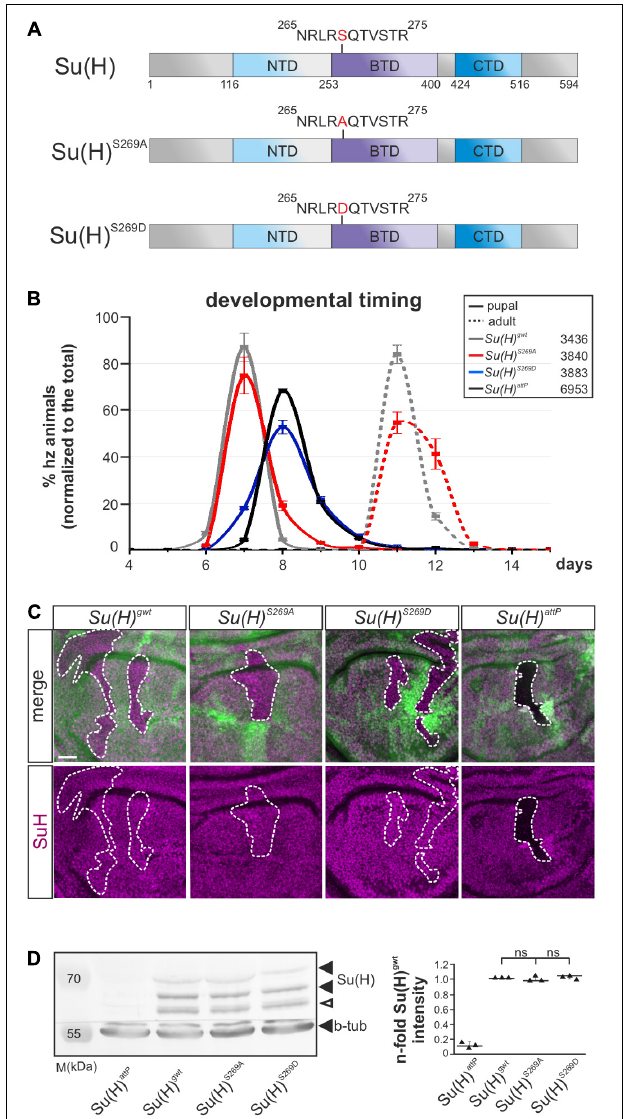
FIGURE 1 | Developmental timing and protein analyses of specific Su(H) S 269 phospho-mutants. (A) Two phospho-specific Su(H) mutants were generated by genome engineering: Su(H) S 269 A (phospho-deficient) and Su(H) S 269 D (phospho-mimetic), replacing serine 269 with either alanine (S269A) or aspartic acid (S269D). Shown are the schemes of the Su(H) wt , Su(H) S 269 A , and Su(H) S 269 D proteins, including the three domains, N-terminal (NTD, light blue), beta-trefoil (BTD, purple), and C-terminal domain (CTD, dark blue). (B) Pupal formation (solid lines) and eclosion of adults (broken lines), respectively, monitored over time (in days after egg deposition), is given as percentage of homozygotes normalized to the total number of offspring. Ten experiments were sampled; s.d. is depicted. Genotypes and total number of animals analyzed are given in the box. (C) Cell clones were induced in wing imaginal disks to monitor Su(H) protein abundance (magenta): wild type cells are marked with GFP, homozygous cells of the indicated genotypes lack GFP (encircled by a dashed line). No difference in protein abundance and localization could be detected between the Su(H) phospho-mutant variants and Su(H) gwt , whereas Su(H) attP null mutant clones were devoid of Su(H) protein as expected. Scale bar represents 25 µ m for all panels. (D) Left panel: Western blot of protein extracts from homozygous larvae of the